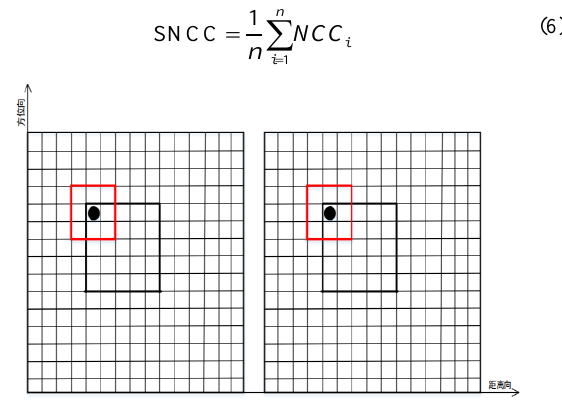
Figure 2. SNCC calculation diagram